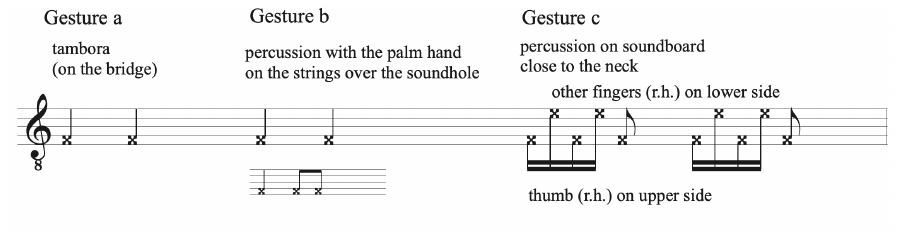
Figure 10. Musical excerpt